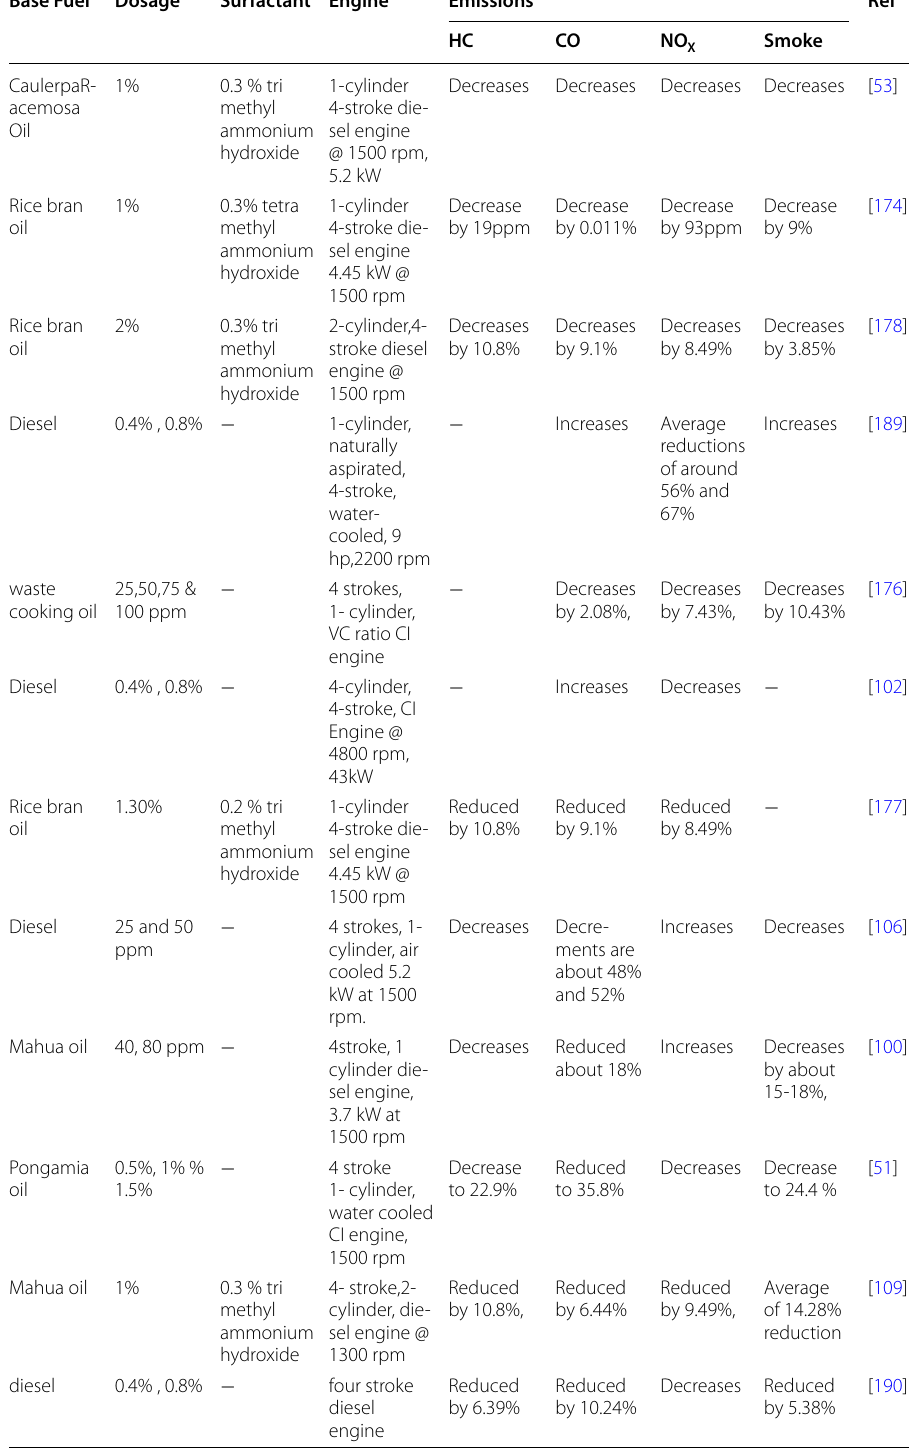
Table 6 Summary of magnetite nanoparticles on Emission characteristics with various concentrations Base Fuel